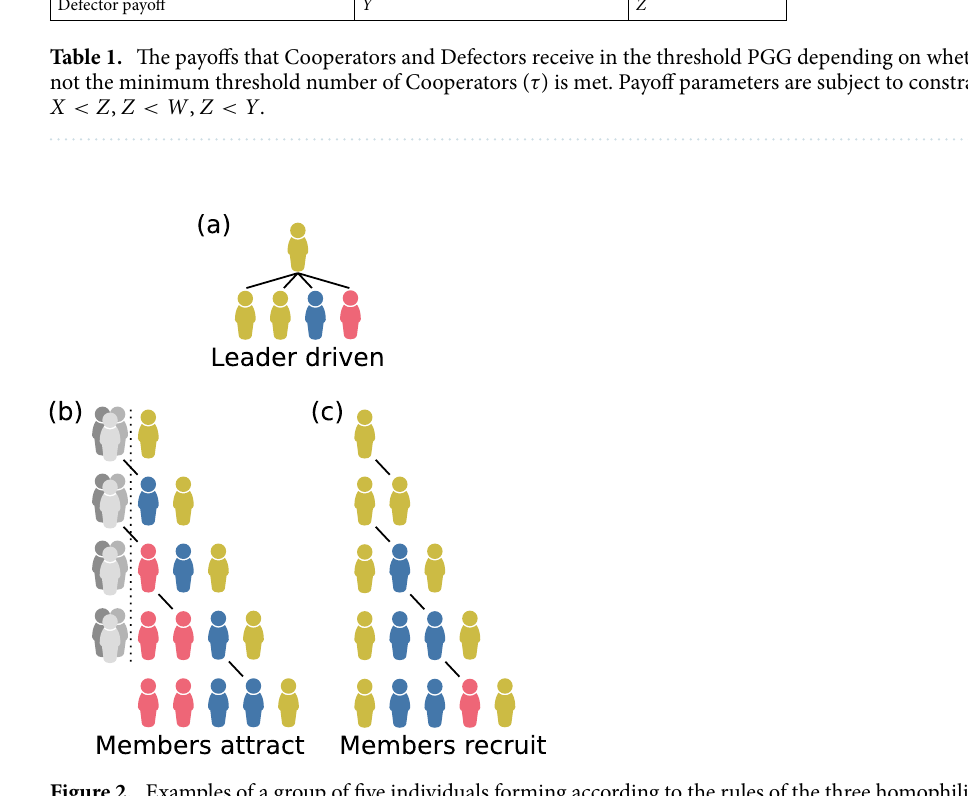
Figure 2. Examples of a group of five individuals forming according to the rules of the three homophilic group-formation models: ( a ) leader driven, ( b ) members attract, and ( c ) members recruit. Current members sequentially recruit or attract new members (lines) who tend to be kin (same colour). The grey group in ( b ) represents attraction of nonkin to the group